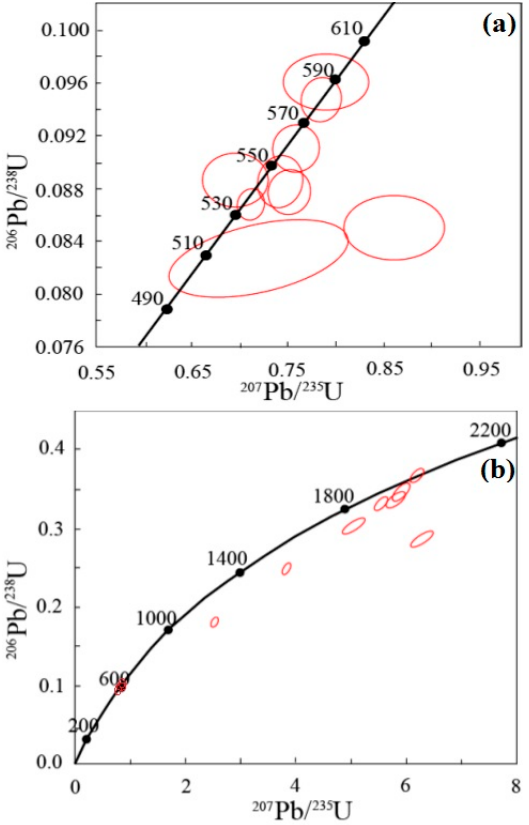
Figure 7. U-Pb zircon concordia plot and age determination for ( a ) Otu granitic pegmatite and ( b ) Babi mica schist (modified from [5]).